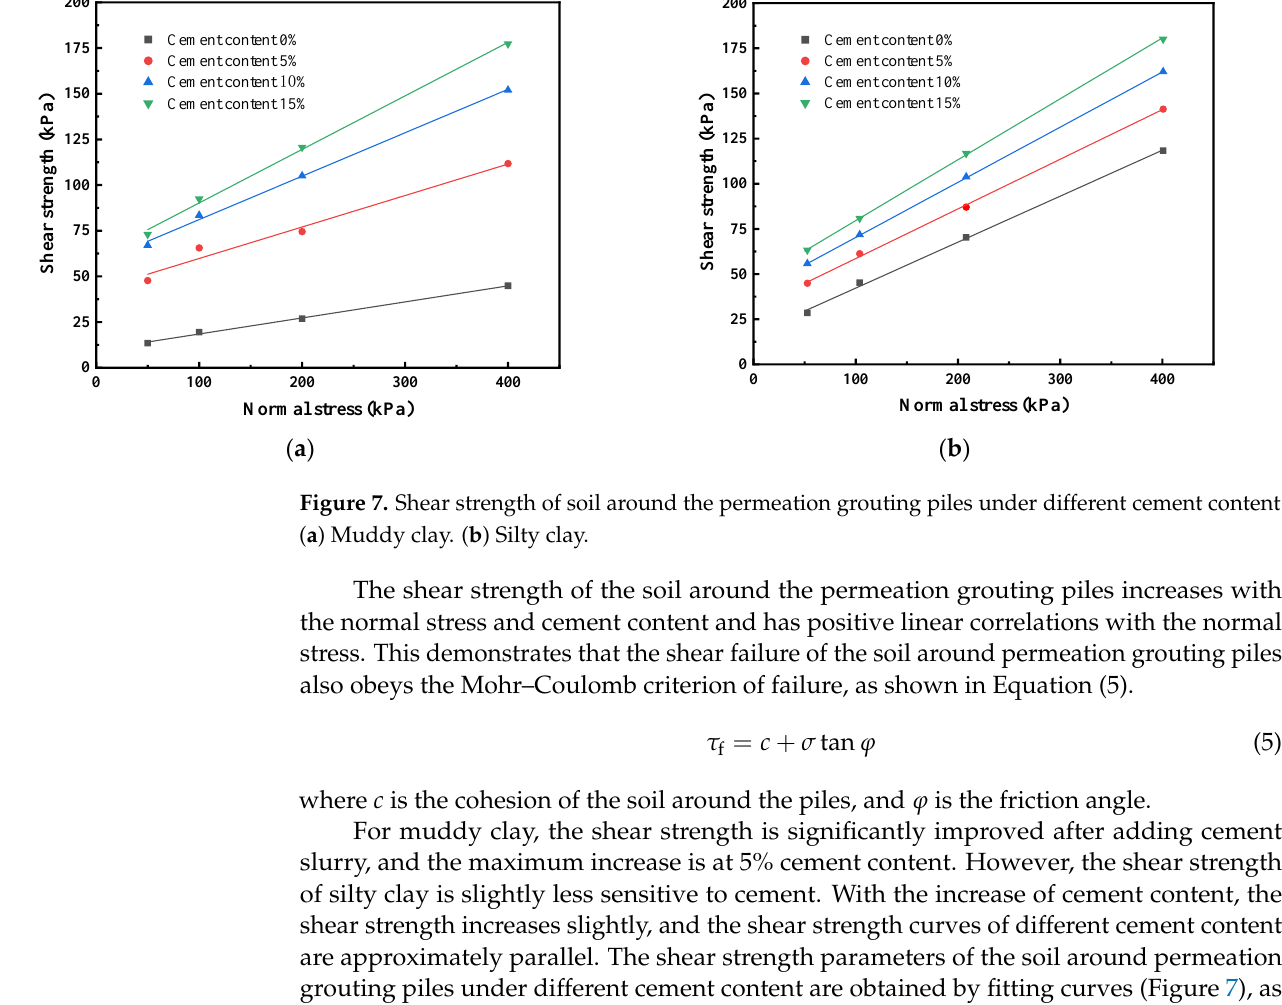
( d ) Figure 6. Curves of shear stress and shear displacement of silty clay. ( a ) σ = 5 0 kPa. ( b ) σ = 1 00 kPa. ( c ) σ = 2 00 kPa. ( d ) σ = 4 00 kPa. The variation trend of permeation grouting silty clay is generally consistent when the cement content is less than 15%. Each curve reaches or approaches its stable state before the maximum shear displacement, and the shear stress does not increase at this time. However, the shear stress ‒shear displacement curve increases approximately linearly when the cement content is 15%, and then the growth rate decreases gradually. The shear stress decreases after reaching the peak and finally remains at the stress value after spec- imen failure. This result indicates that the cement content of the slurry can change the